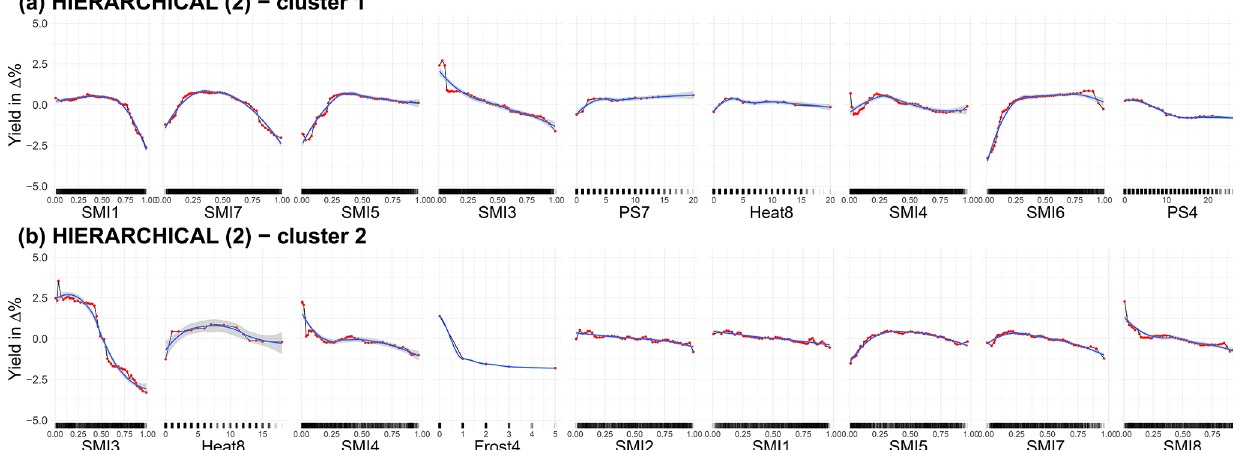
Figure A5. ALE plots for the best combination of cluster algorithm and cluster size (HIERARCHICAL with two clusters) for a soil moisture index configuration that only considers the uppermost 25cm. For both clusters, the nine ALE plots with the highest feature importance are shown. The importance ranking is established with 50 repetitions. We have chosen a grid size of 50 to estimate the ALE plots, which allows us to reveal the true complexity of the model at the expense of shakiness. Therefore a non-linear smoothing function (LOESS – locally estimated scatterplot smoothing) is added in blue (with the confidence interval in grey). SMI represents the soil moisture index for the uppermost 25cm of the soil column, PS stands for days without rain in a given month, and Heat stands for days with a maximum temperature of more than 30 ◦ C. The number indicates the month; October (10) to December (12) refers to the year